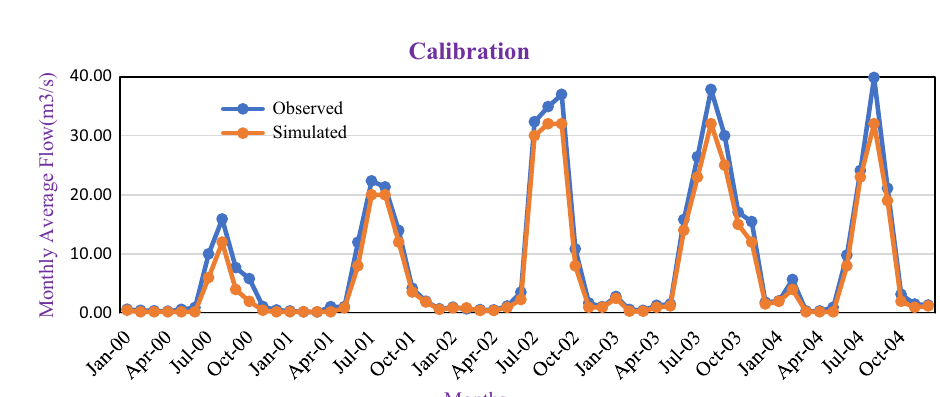
Fig. 11 Monthly average flow between observed and simulated (2000–2004)